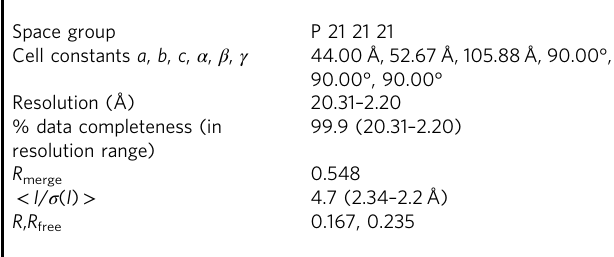
Table 2 Crystallographic statistics of VDR LBD and